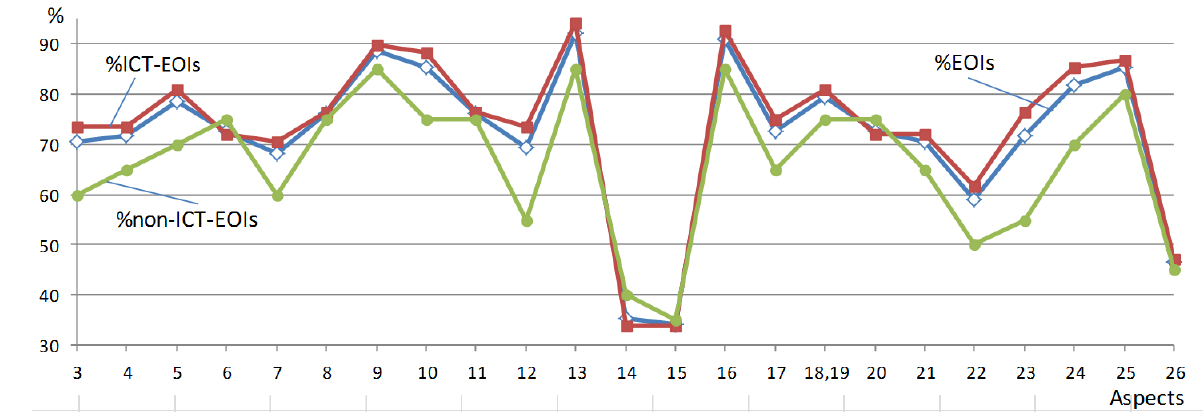
Figure 1. The %EOls, %ICT-EOls and %non-ICT-EOls dependence on aspects 3 – 26 at 100% i-security